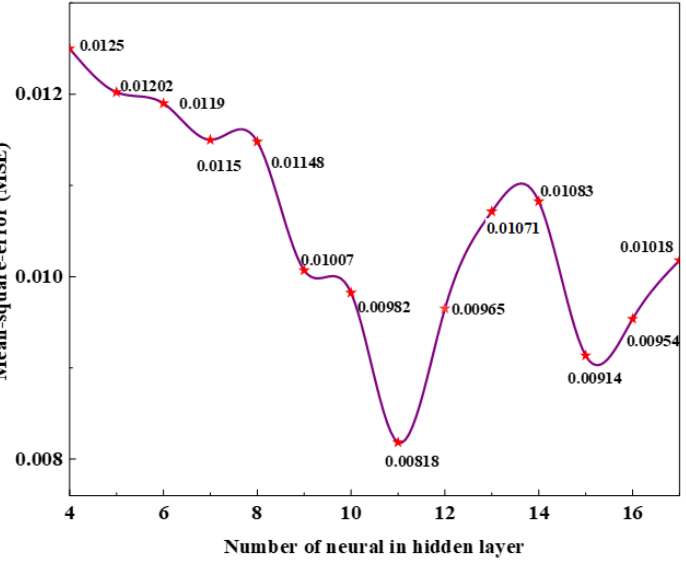
Figure 3. Mean square error (MSE) under the combination of nodes in different hidden